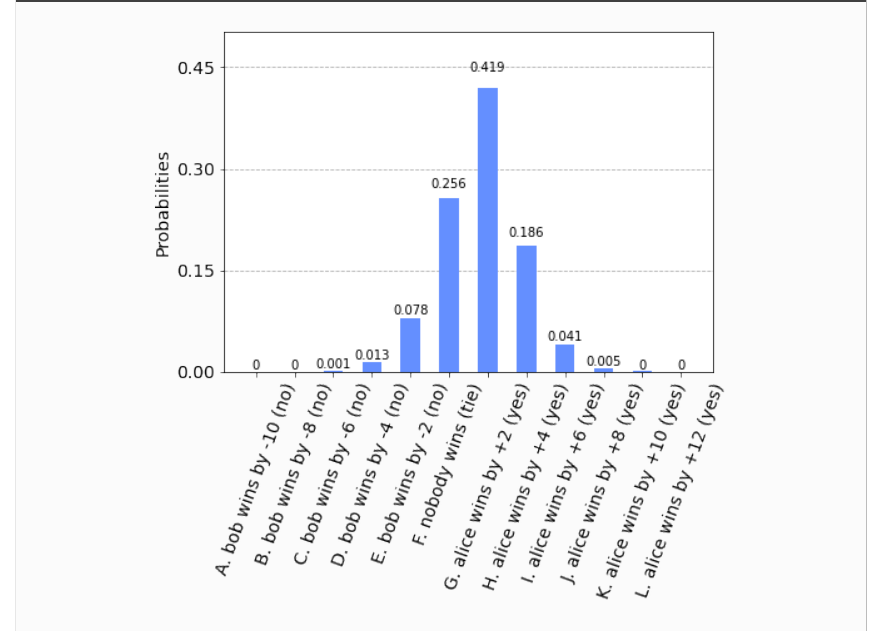
Figure 7. The possible outcomes and their probabilities when r A = r B =